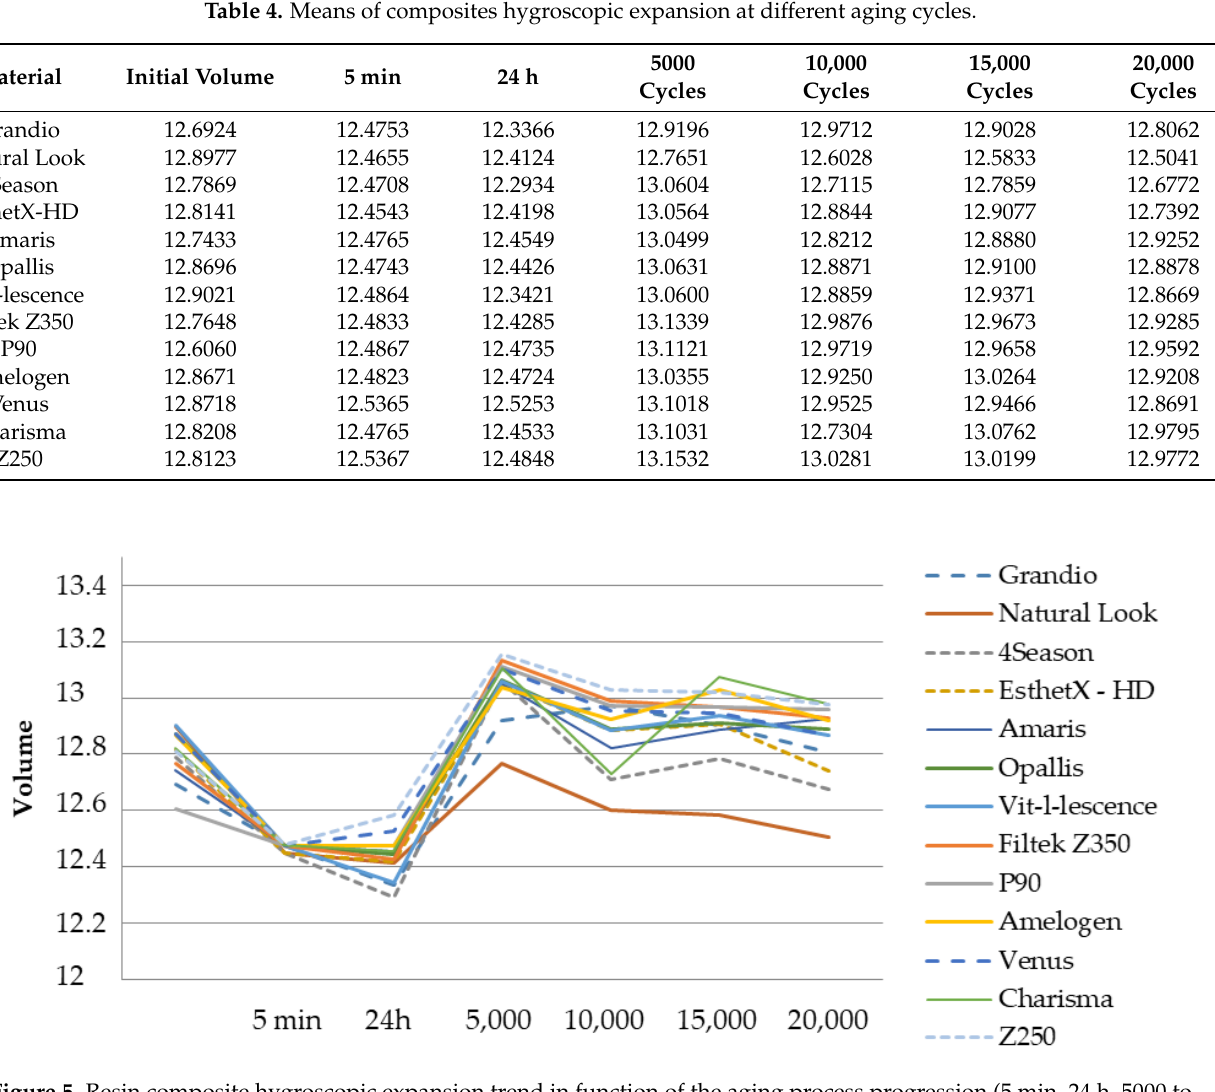
Figure 6. Tukey (95%) comparison for the difference of volume between the groups according to the different period of evaluation. After normality check, the one-way ANOVA was performed considering Material as a factor for the evaluation of the elastic modulus, Poisson ratio, and degree of conversion data sets. The ANOVA test for the elastic modulus (GPa) presented F-value = 5.61 and p - value < 0.001 (Supplementary material: Table S3), while the for Poisson ratio presented F-